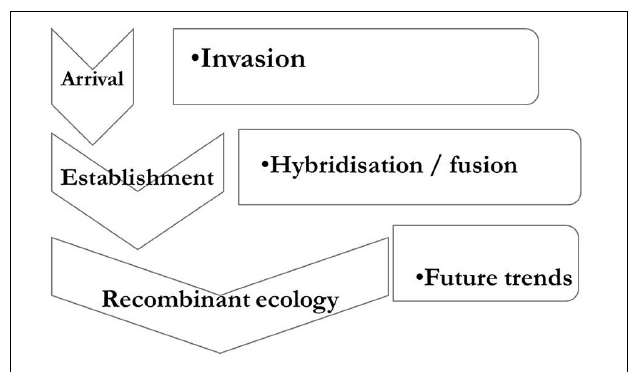
FIGURE 11 | Development of recombinant futurescape ecology along the urban River Don.